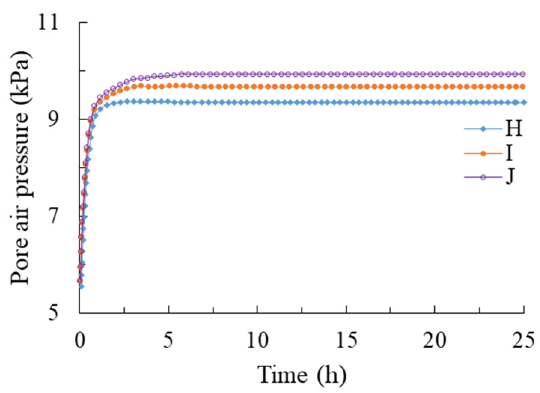
Figure 5. Time series of pore gas pressure at three monitoring